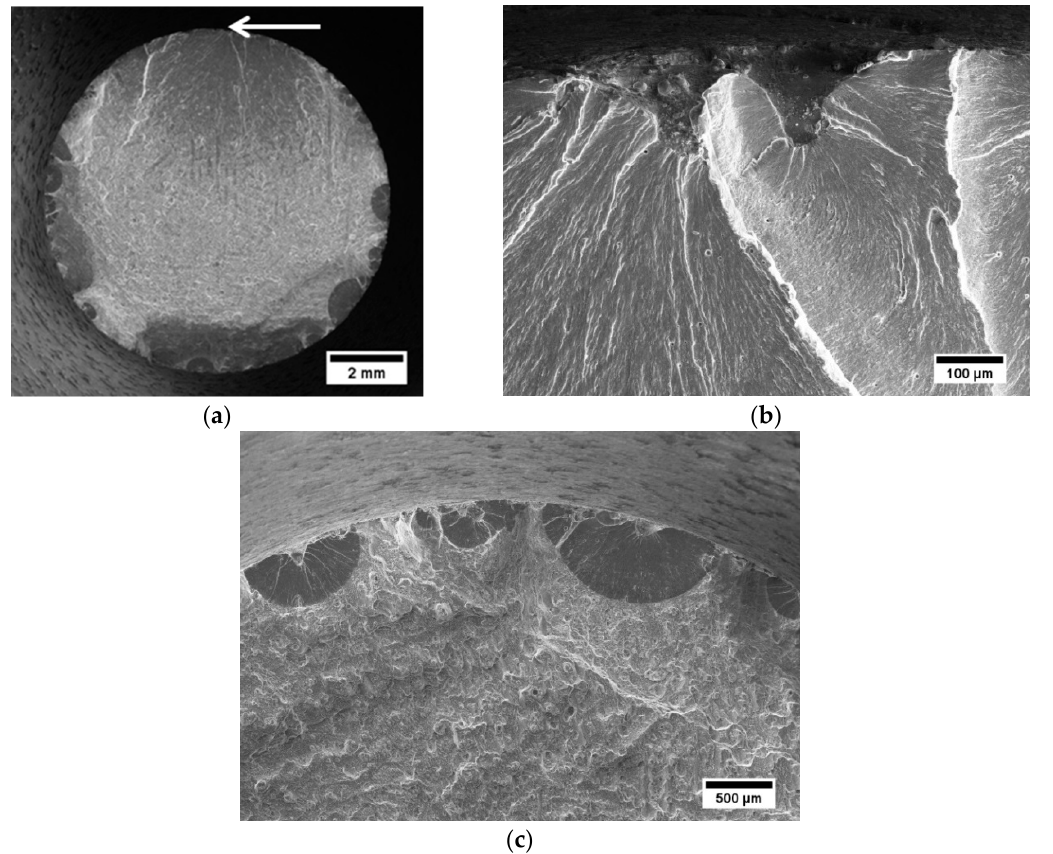
Figure 13. Fracture surface of a VF sample failed at a maximum stress of 175 MPa; ( a ) main crack nucleation site (arrowed); ( b , c ) secondary multiple crack nucleation sites.